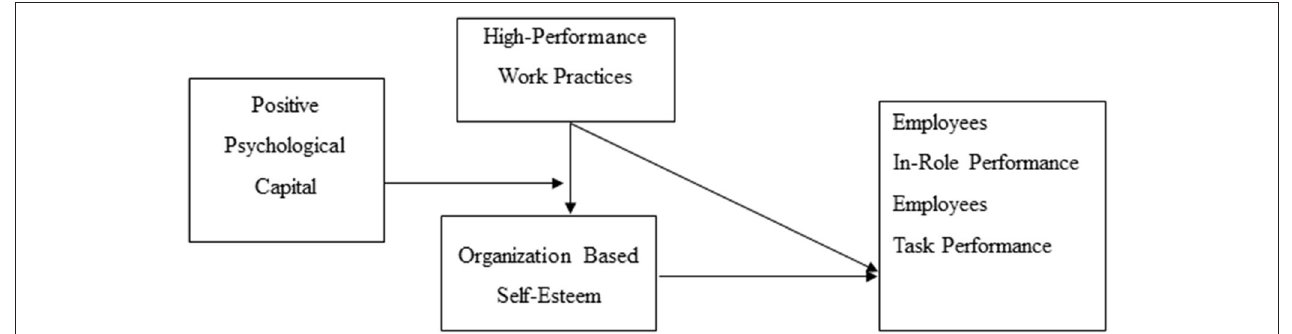
FIGURE 1 | Conceptual